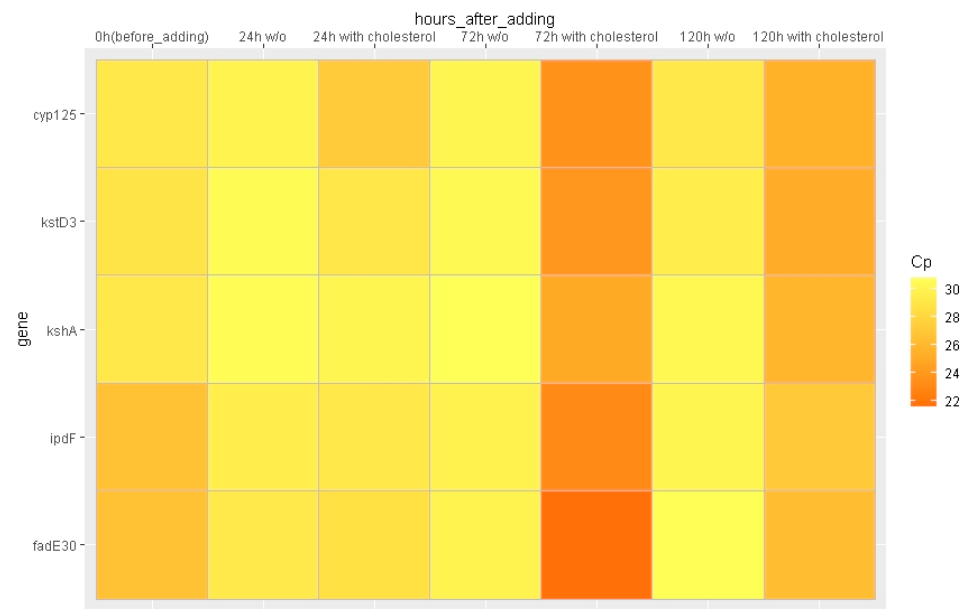
Figure 6. Heat map. The X-axis represents the sampling time for control and variant with choles- terol; the Y-axis represents the genes of interest. Crossing point (Cp) shows the cycle number for each gene of interest as normalized to the Cp of the 16S rRNA. Lower Cp values (higher expression) are brighter colors.